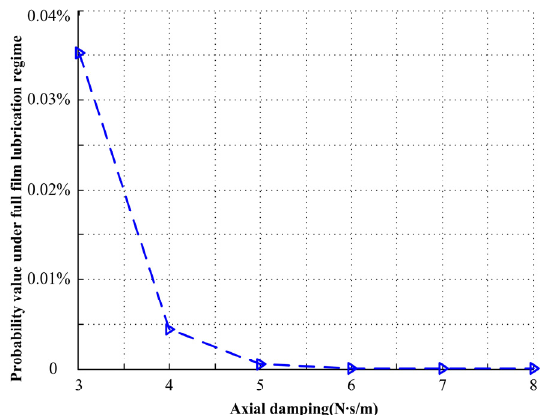
Figure 10. Probability density of closing force F cl under different axial damping and the relationship with duty parameter G.